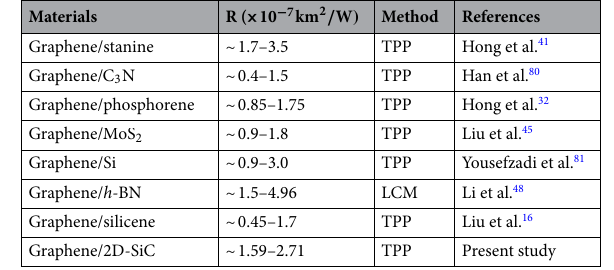
Table 1. A comparison of the thermal interface resistance for different 2D heterobilayers determined from MD simulation. LCM lumped capacity